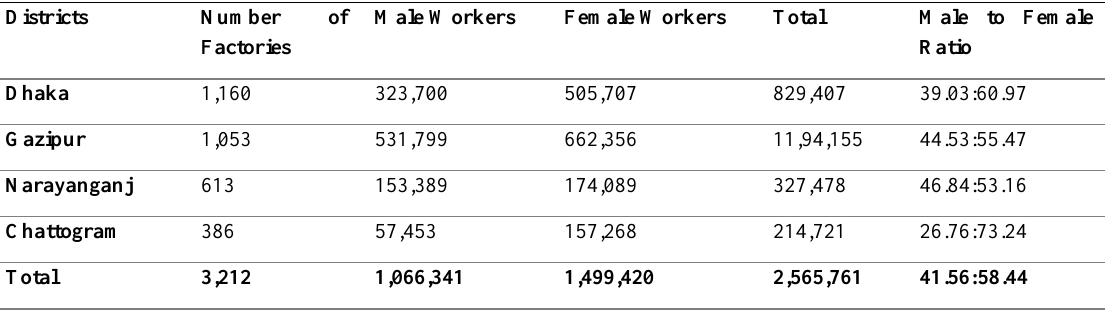
Table 1: Districts wise Garments Factories and Garments Workers’ Ratio